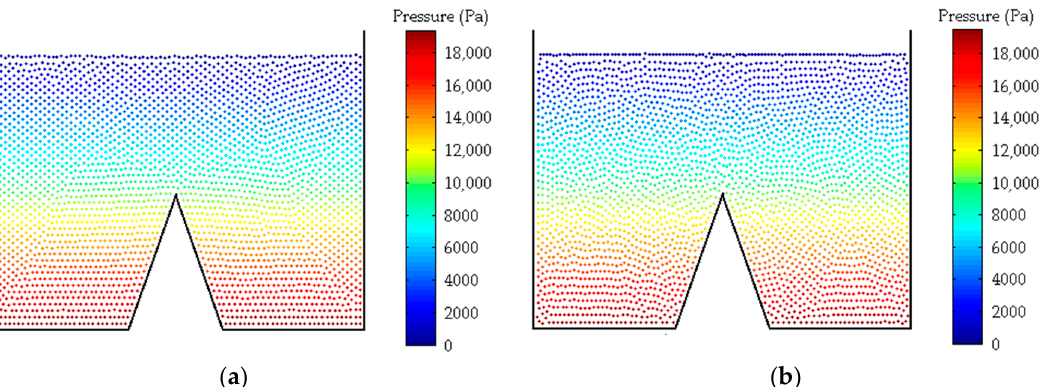
Figure 6. Pressure field and particle distribution snapshots at 15 s for different smoothing lengths ( a ) h = 1.33 ∆ x and ( b ) h = 2.00 ∆ x .